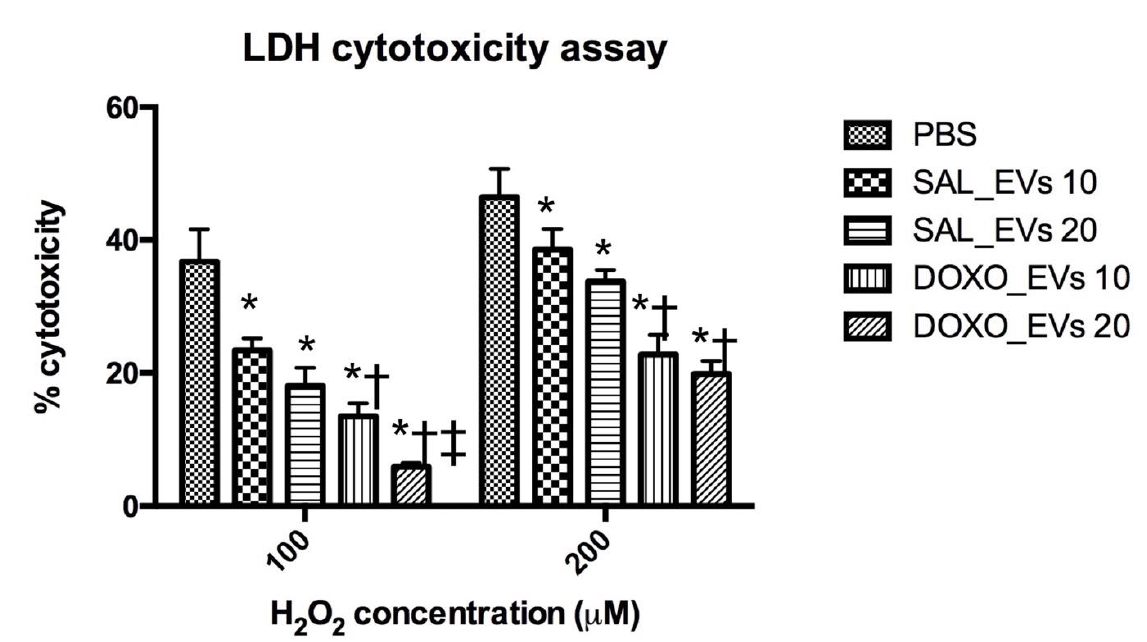
Figure 5. Percentage of cell death measured by LDH cytotoxicity assay in H9c2 cells pre-incubated with PBS, SAL_EVs or DOXO_EVs followed by 100 or 200 𝜇 M H 2 O 2 exposure for 24 h. SAL_EVs 10 = H9c2 cells pre-incubated with SAL_EVs 10 × 10 9 particles/mL, SAL_EVs 20 = H9c2 cells pre-incubated with SAL_EVs 20 × 10 9 particles/mL; DOXO_EVs 10 = H9c2 cells pre-incubated with DOXO_EVs 10 × 10 9 particles/mL; DOXO_EVs 20 = H9c2 cells pre-incubated with DOXO_EVs 20 × 10 9 particles/mL; * p < 0.05 vs. no EV treated control (PBS), † p < 0.05 vs. SAL_EVs 10 × 10 9 particles/mL; ‡ p < 0.05 vs. DOXO_EVs 10 × 10 9 particles/mL.